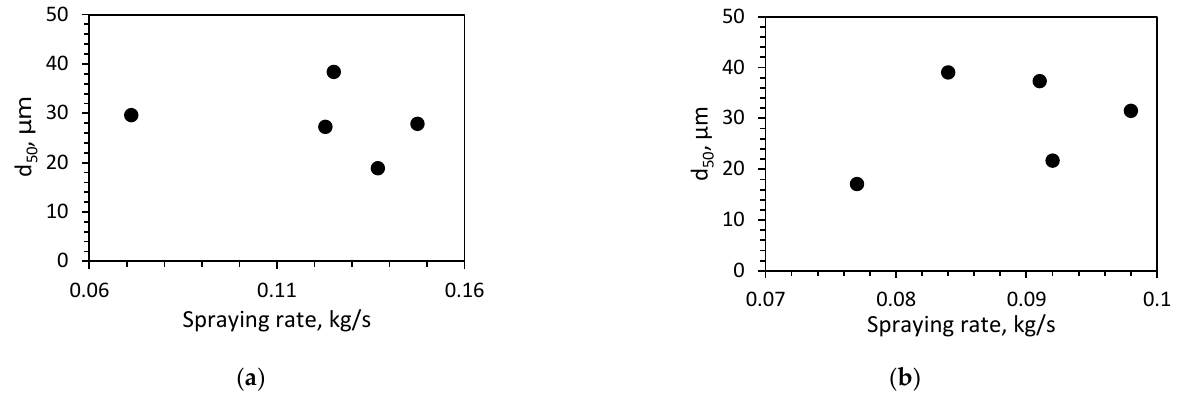
Figure 4. Effect of spraying rate on the median particle size of atomized powder d 50 : for viscosity modified 16-7-6 steel [12] ( a ); and for ST-modified 16-7-6 steel [11] ( b ).